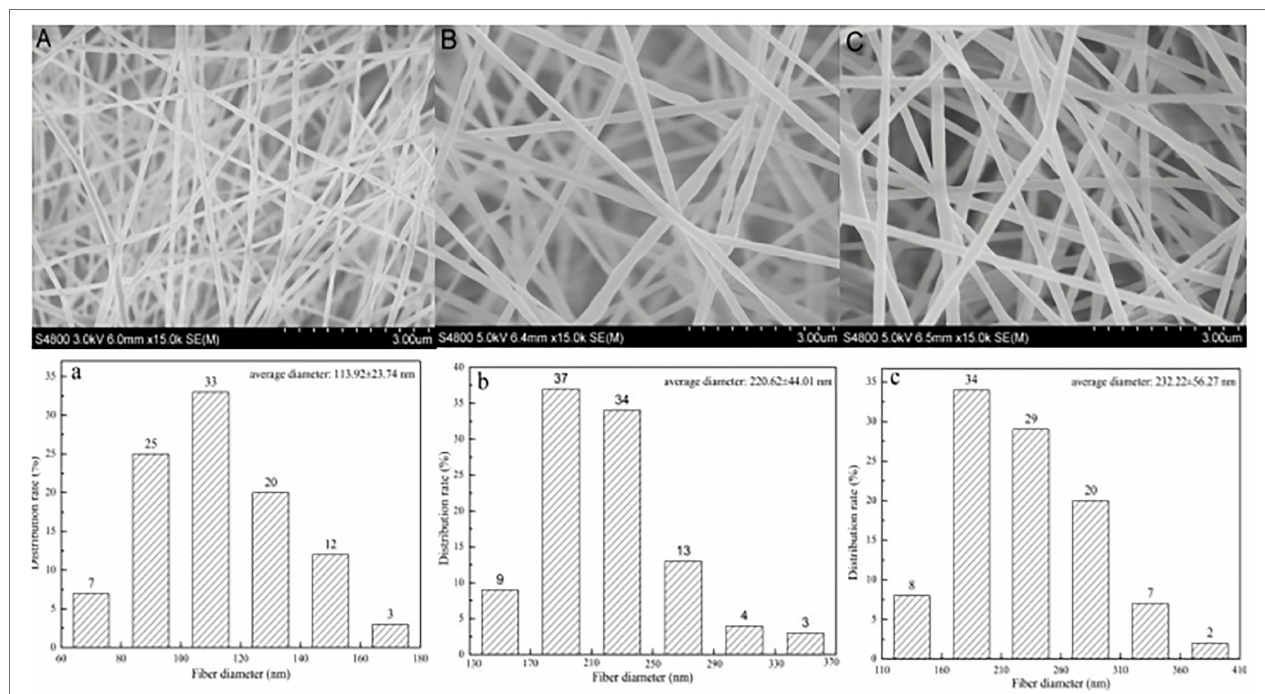
FIGURE 1 | SEM images of (A) PCL fibrous membrane, (B) 20% LL/PCL fibrous membrane, (C) 40% LL/PCL fibrous membrane; and fiber diameter distribution of (a) PCL fibrous membrane, (b) 20% LL/PCL fibrous membrane, (c) 40% LL/PCL fibrous membrane.